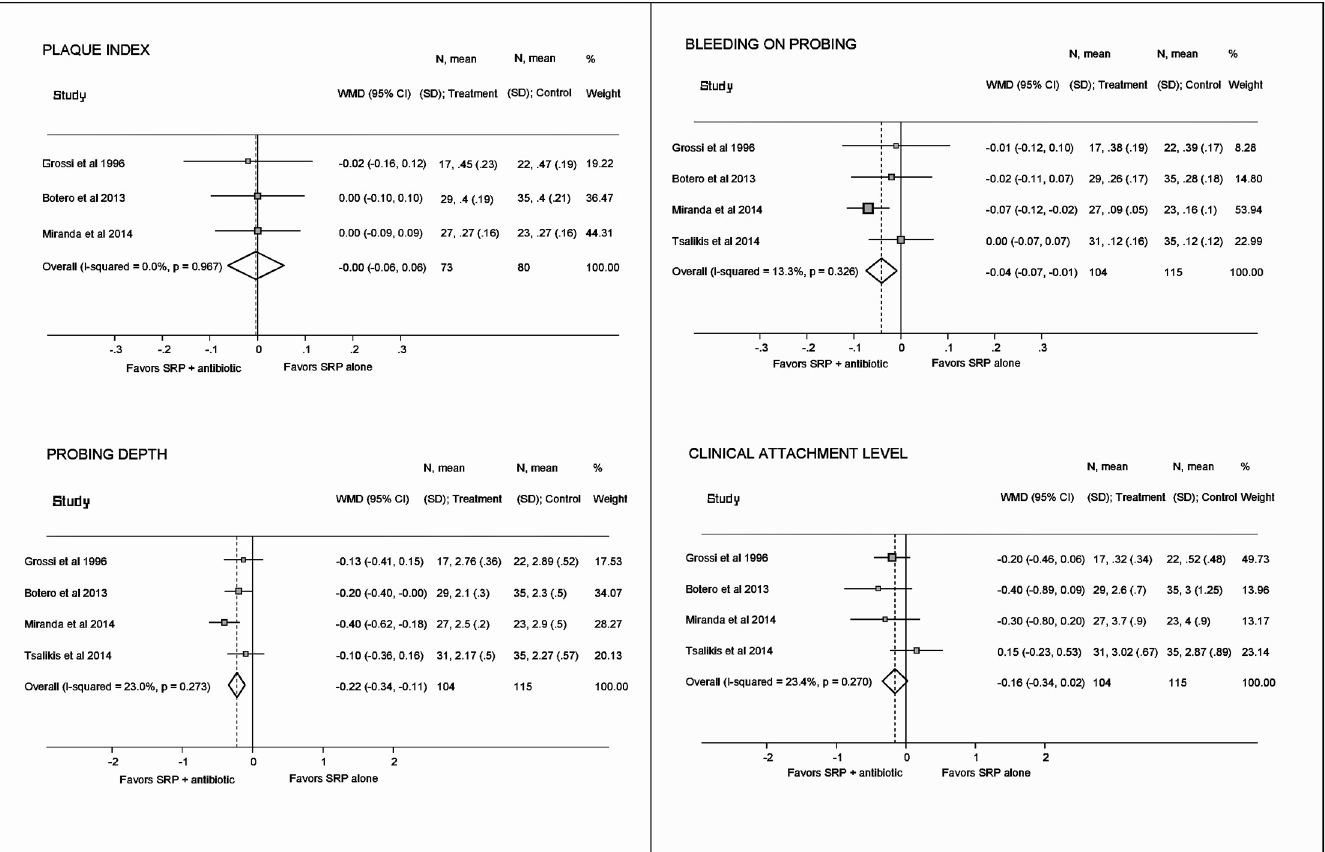
Fig 3. Forest plots presenting pooled weighted mean differences and 95% confidence intervals for periodontal parameters between test and control